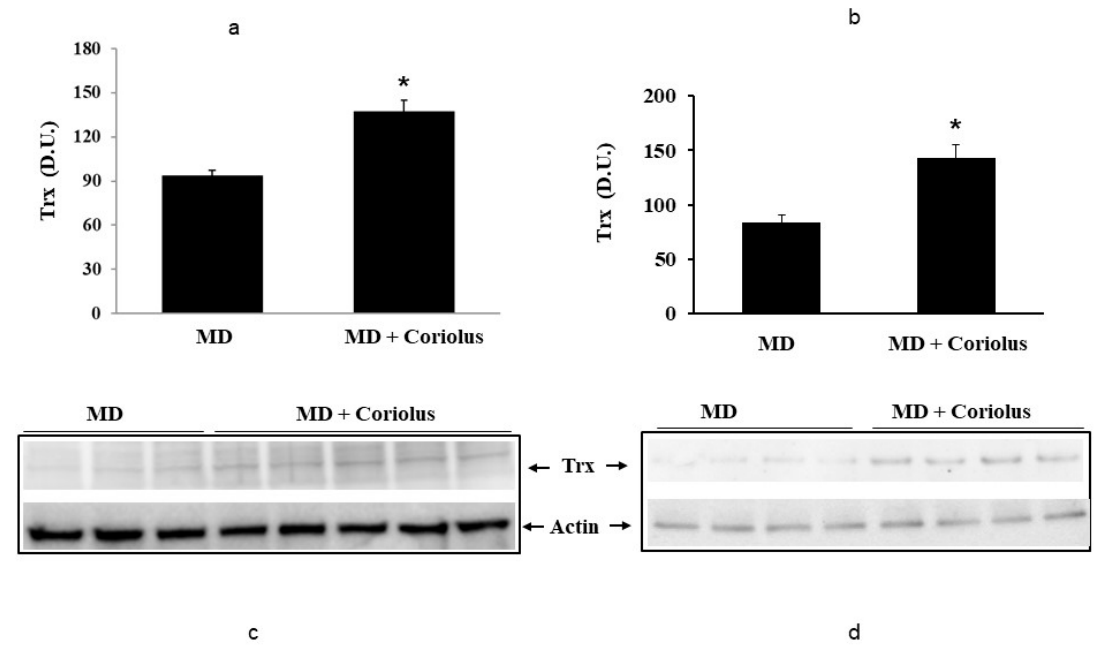
Figure 4. Thioredoxin levels in lymphocytes and in plasma from MD patients. Lymphocyte samples ( a ) and plasma samples ( b ) from MD patients were assayed for thioredoxin (Trx) by western blot as described in Materials and Methods. A representative immunoblot is shown ( c , d ). β -actin has been used as loading control. * p < 0.05 vs. MD alone. D.U., densitometric units.